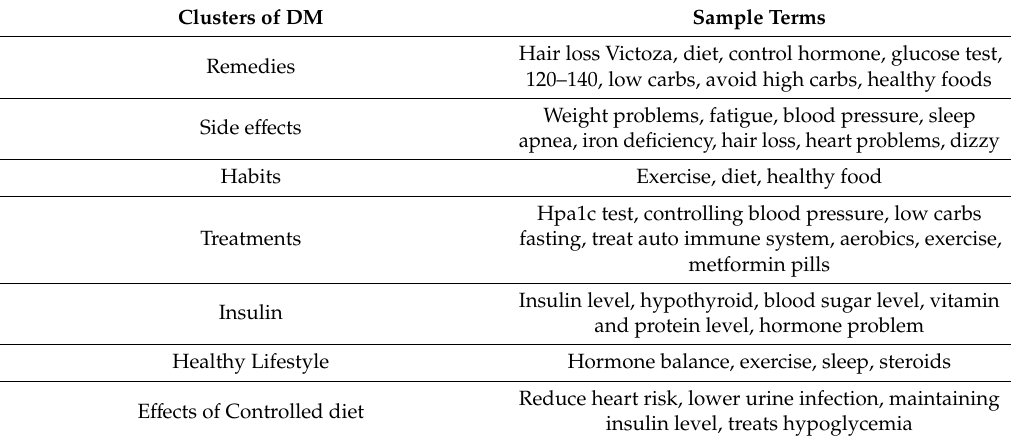
Table 2. Sample keywords extracted from each cluster of diabetes mellitus (DM).